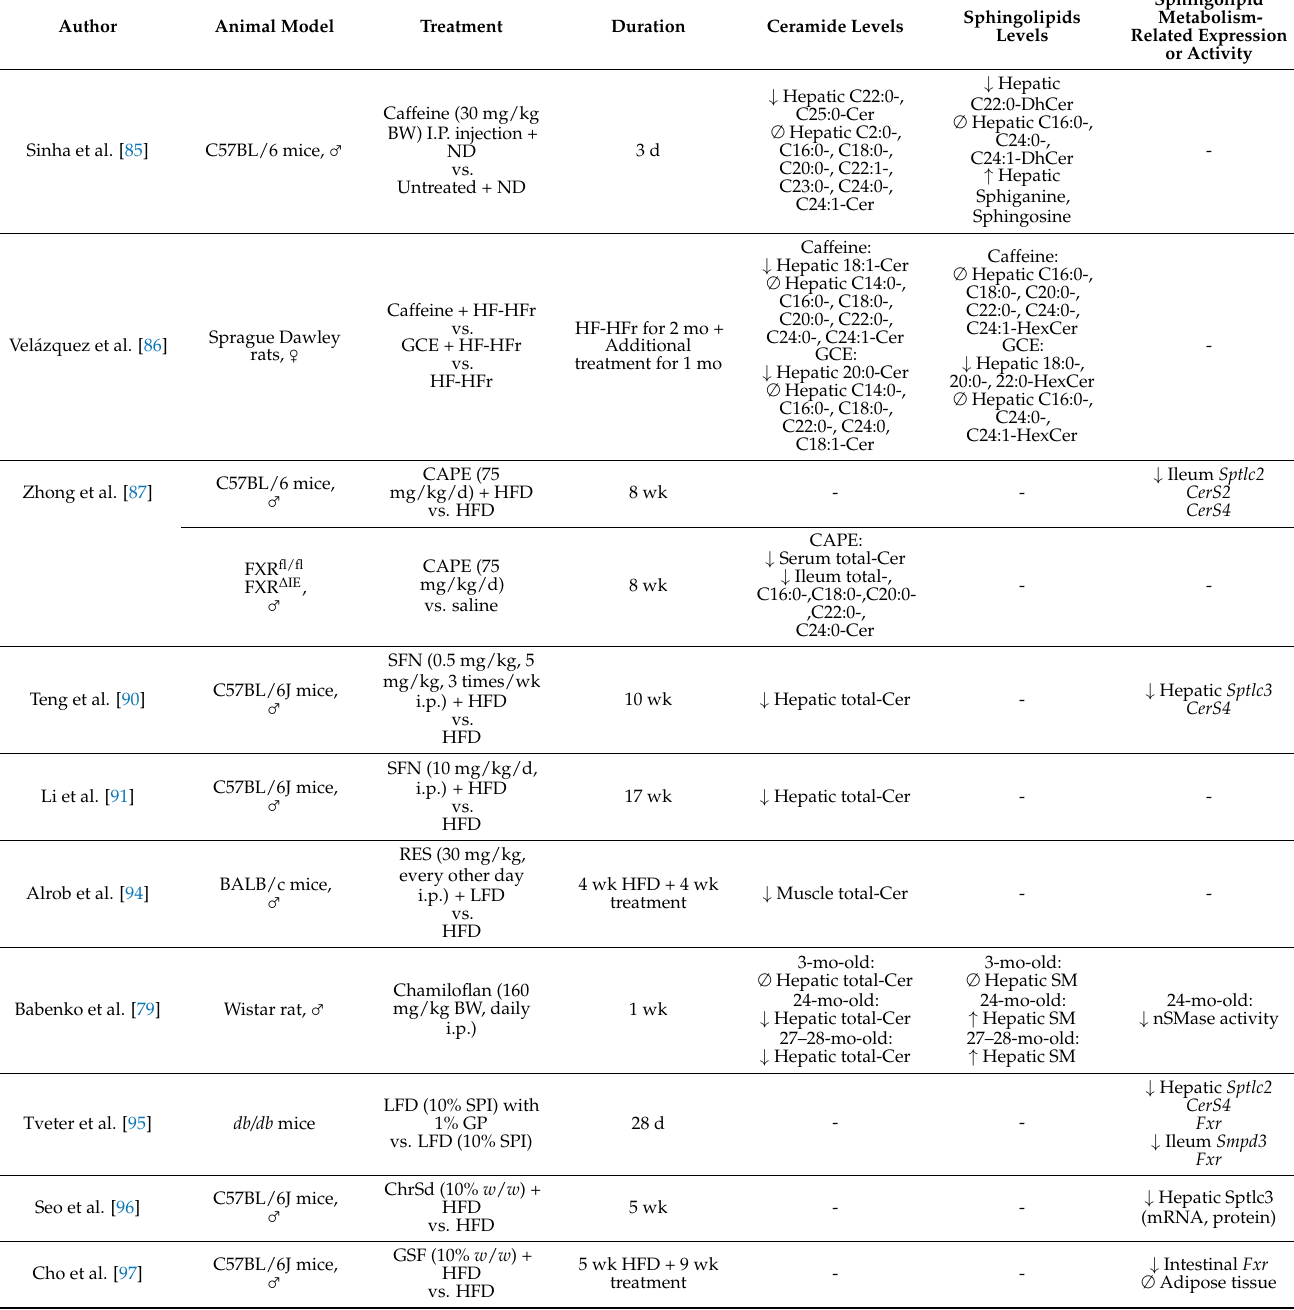
Table 2. Summary of animal studies examining the impact of phytochemical consumption on sphingolipid levels and related